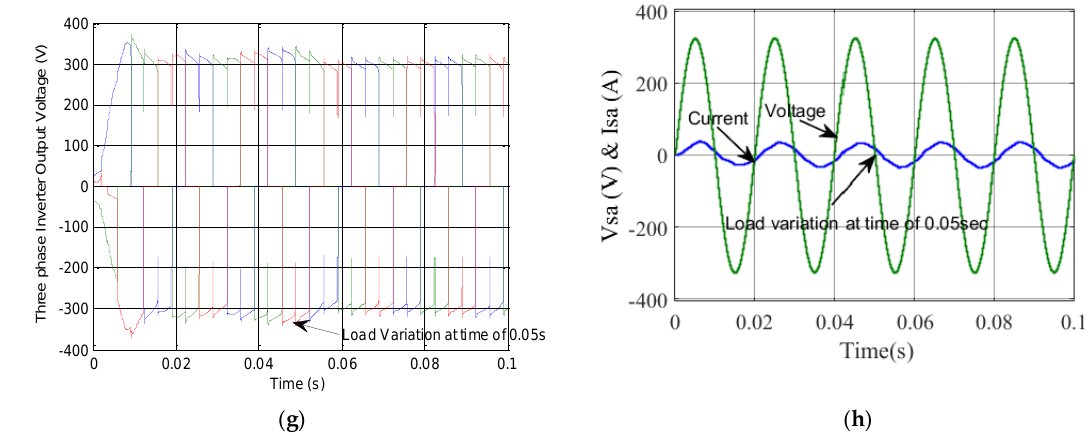
Figure 9. Simulated responses of three phase SSI-based SAPF connected at DRB—RL load with HCC and FLC: ( a ) Supply current, ( b ) load current, ( c ) compensation current, ( d ) THD, ( e ) V 2 DC link voltage, ( f ) V 1 DC link voltage, ( g ) SSI output voltage and ( h ) source voltage (V sa ) and source current (I sa ) of Phase A.